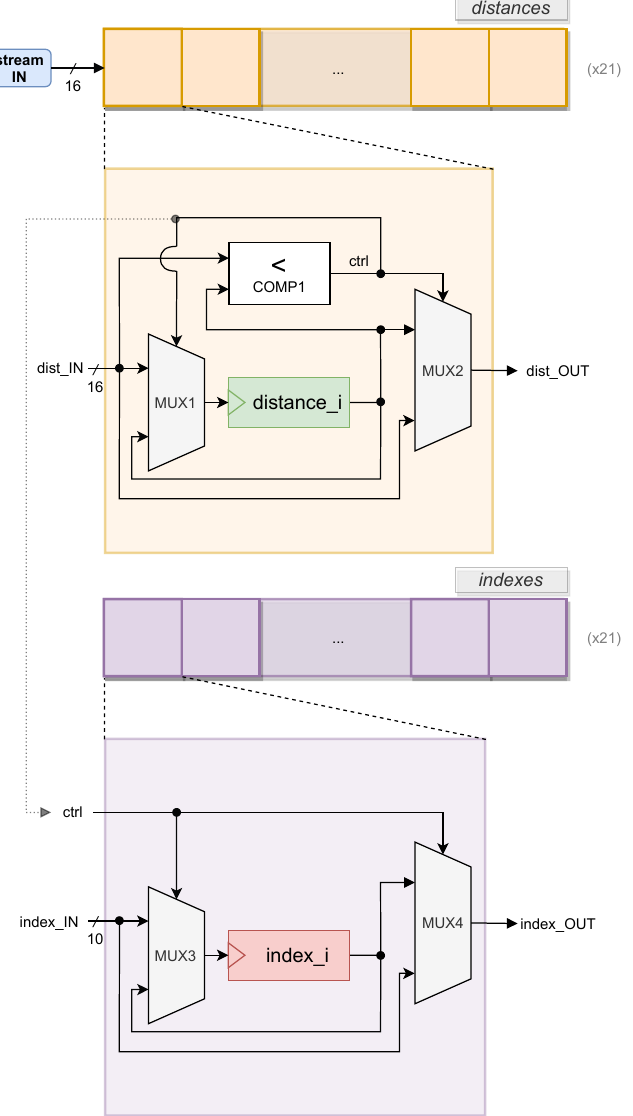
Figure 8. Block diagram of sort distances core, inspired from